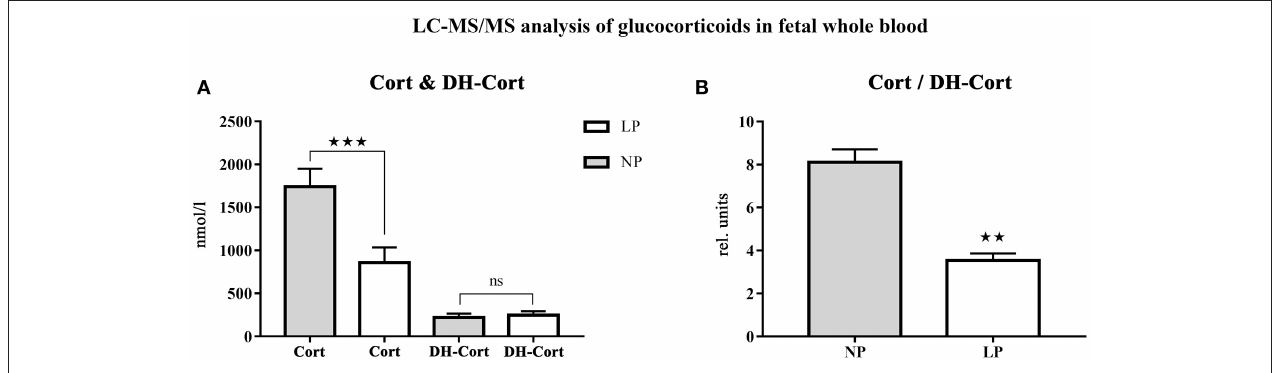
FIGURE 2 | LC-MS/MS analysis of circulating glucocorticoid levels in fetal whole blood. (A) Differences of circulating corticosterone (Cort) and 11-dehydrocorticosterone (DH-Cort) levels of fetal NP ( n = 4) and LP ( n = 5) whole blood (pmol/g). (B) Differences of Cort/DH-Cort -ratio in whole blood. Legend: Gray column represents NP group ( n = 4), white column represents LP group ( n = 5), rel. units, relative units; ns, not significant; ** p < 0.01 and *** p < 0.001.